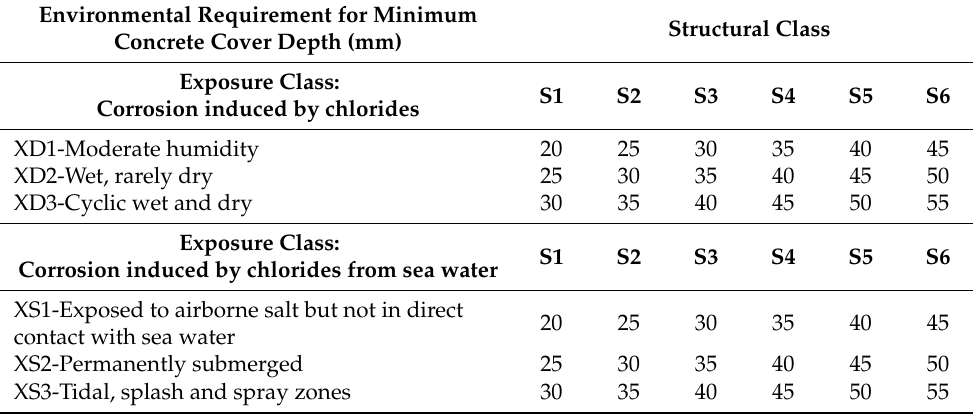
Table 6. Minimum cover depth of concrete (mm) for corrosion induced by